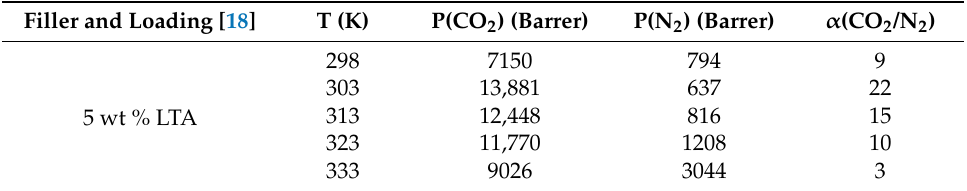
Table A1. Experimental data of the different MMMs with increasing order of particle size (LTA, 0.5 µ m; CHA, 1 µ m; RHO, 1.5 µ